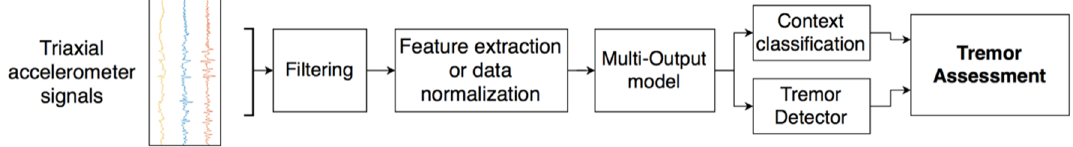
Figure 7. Algorithm for the tremor assessment using a multitask Convolutional neural network (CNN).